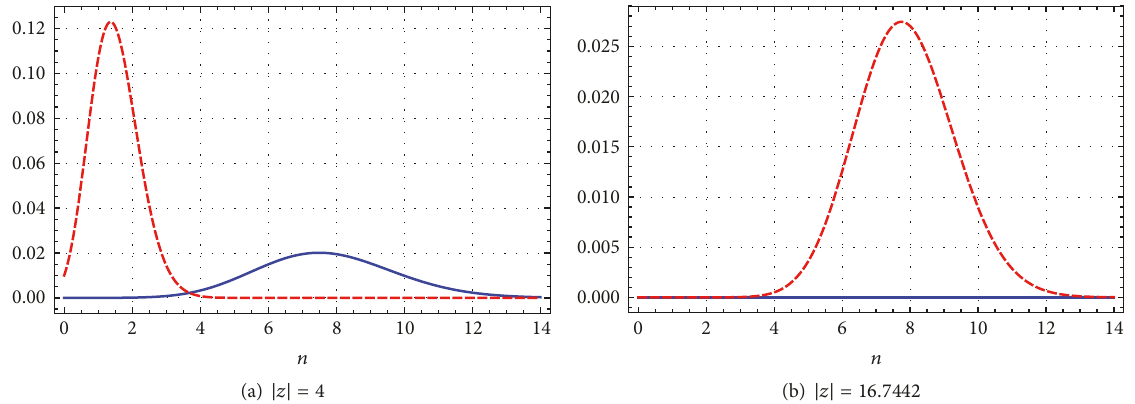
Figure 8: Squeezing along the line 𝑛 = 𝑚 of the photon probability distributions P (𝑛,𝑚,|𝑧|) and P 퐸 (𝑛,𝑚, |𝑧|) , blue and red-dashed, respectively. In (a) the photon number averages for the incoming states |𝑧,0⟩ and |𝑧 퐸 , 0⟩ are, respectively, ⟨̂𝑛⟩ = 16 and ⟨̂𝑛⟩ 푧 = 16 . Compare with Figure 5. In all cases the maximum of P (𝑛,𝑚, |𝑧|) and Compare with Figure 3. In (b) we have ⟨̂𝑛⟩ = 280.369 and ⟨̂𝑛⟩ 푧 퐸 P (𝑛,𝑚, |𝑧|) is reached at ⟨̂𝑛⟩/2 and ⟨̂𝑛⟩ /2 , 퐸 푧 퐸